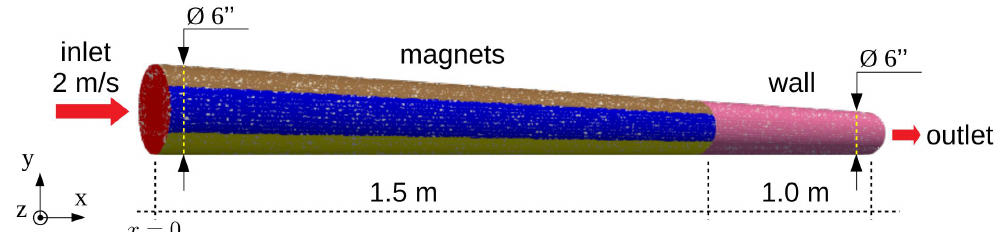
Figure 1. Geometry of the 6-inch diameter cylindrical duct model used in simulations.